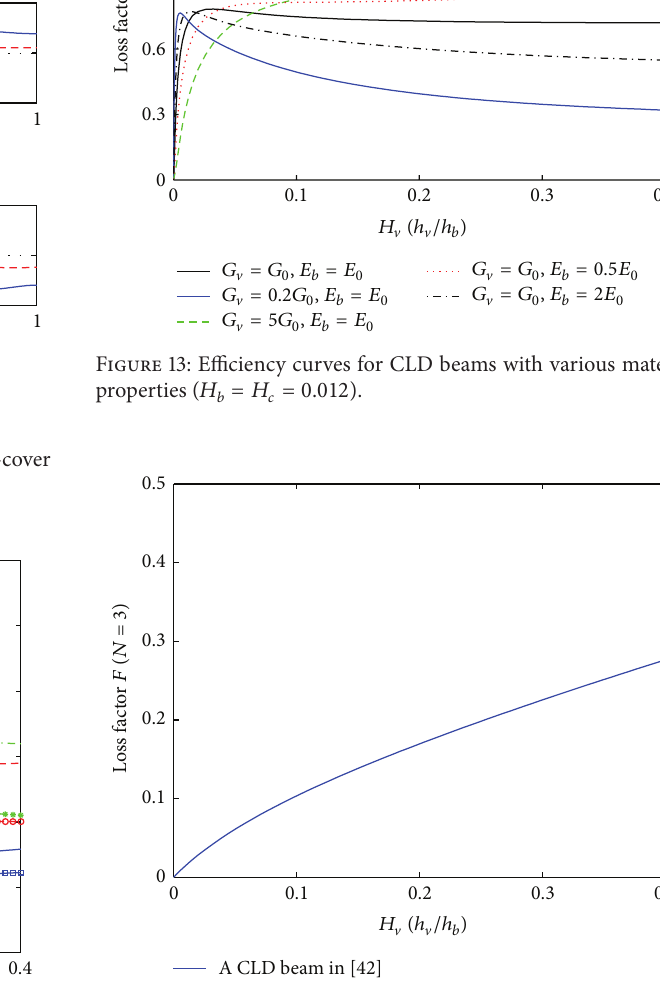
Figure 14: Efficiency curve for a selected CLD beam in